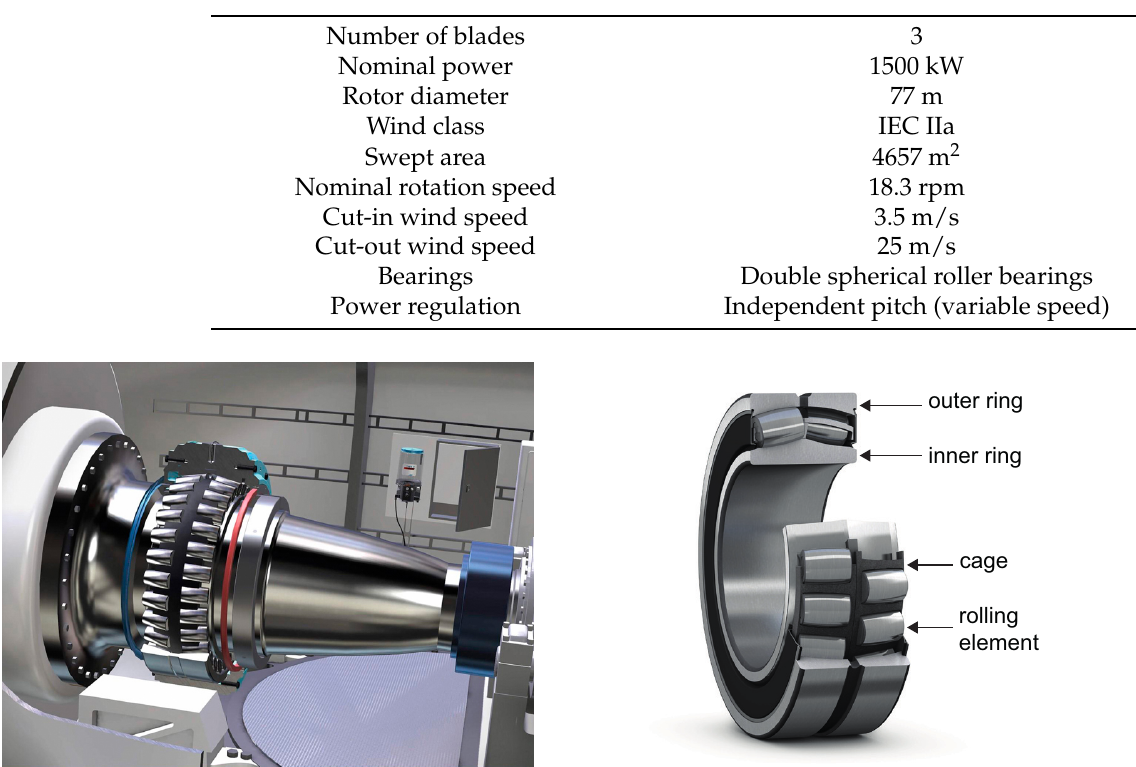
Figure 1. Main components of the wind turbine (WT) [24]. Table 1. Technical specifications of the WTs in the park.